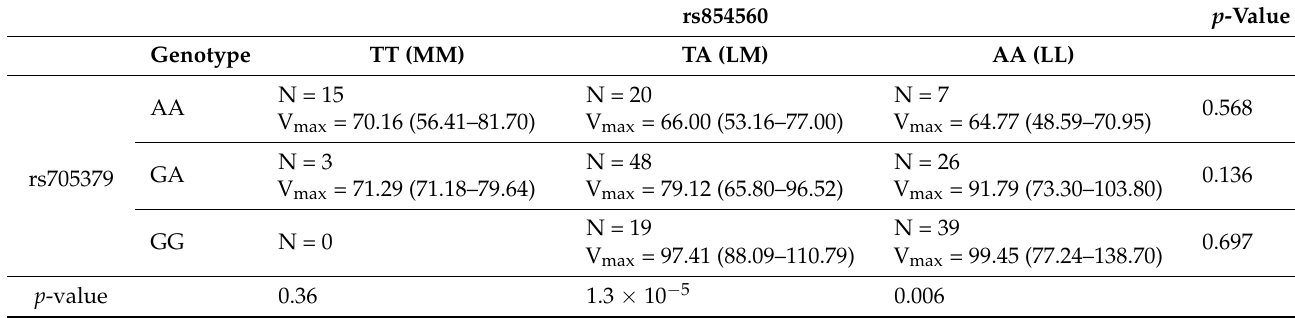
Table 4. Average V max values (in µ M/min) for each pair of genotypes of the PON1 SNPs rs705379 and rs854560. Some pairs of genotypes were not present in any patient in our study (N = 0). A cell shows the number (N) of patients with a certain pair of genotypes and the median (interquartile range) for V max .